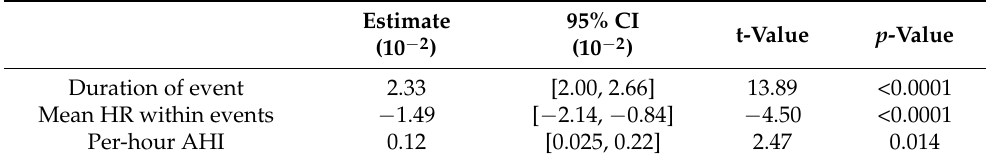
Table 1. The results of the linear mixed-effects model predicting the degree of oxygen desaturation measured at arm muscle.